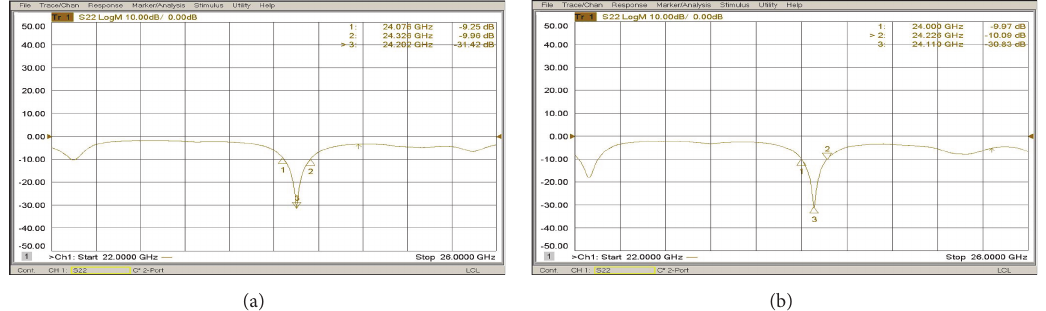
Figure 11: Measured reflection coefficient of the serial array with 8 patches (a) and of the receiving antenna